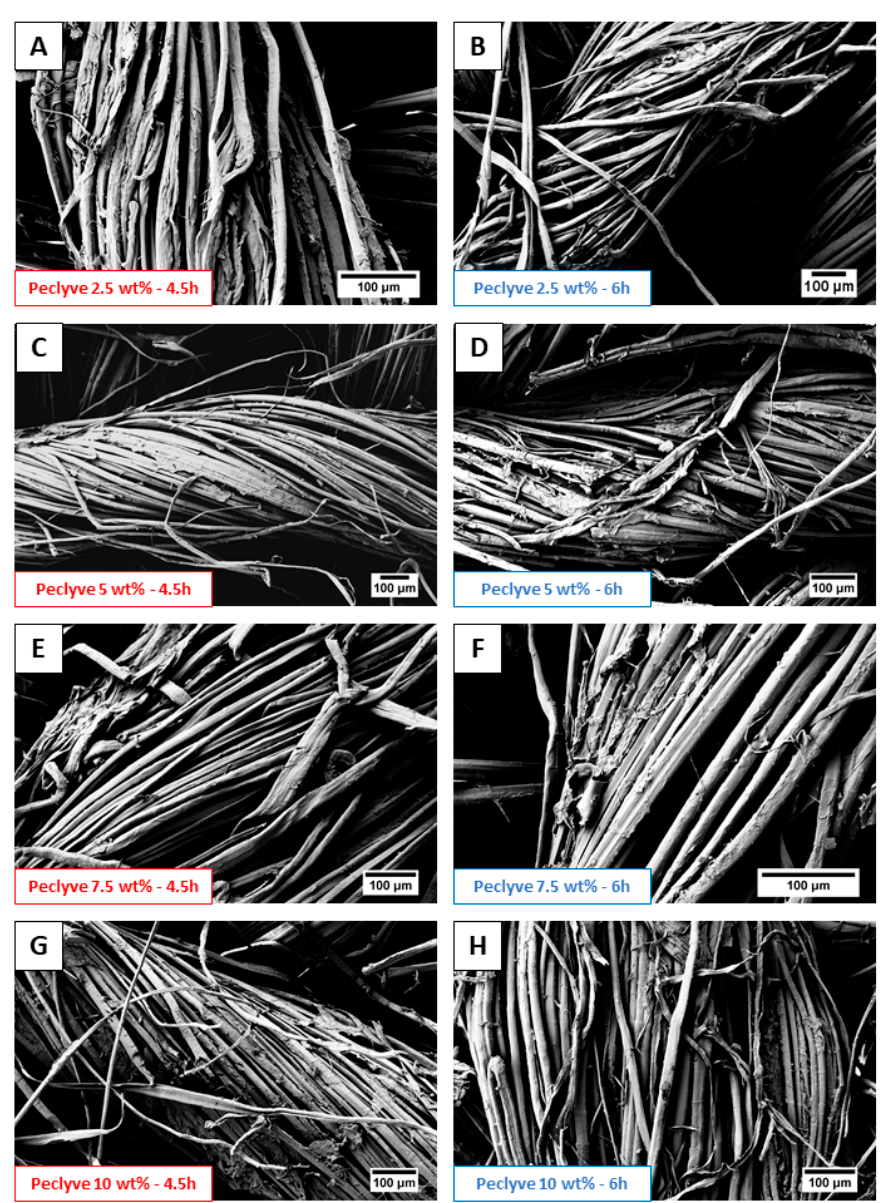
Figure 3. SEM micrographs of the flax yarns as a function of the different enzymatic treatments with Peclyve: ( A ) 2.5 wt %, 4.5 h; ( B ) 2.5 wt %, 6 h; ( C ) 5 wt %, 4.5 h; ( D ) 5 wt %, 6 h; ( E ) 7.5 wt %, 4.5 h; ( F ) 7.5 wt %, 6 h; ( G ) 10 wt %, 4.5 h; ( H ) 10 wt %, 6 h.